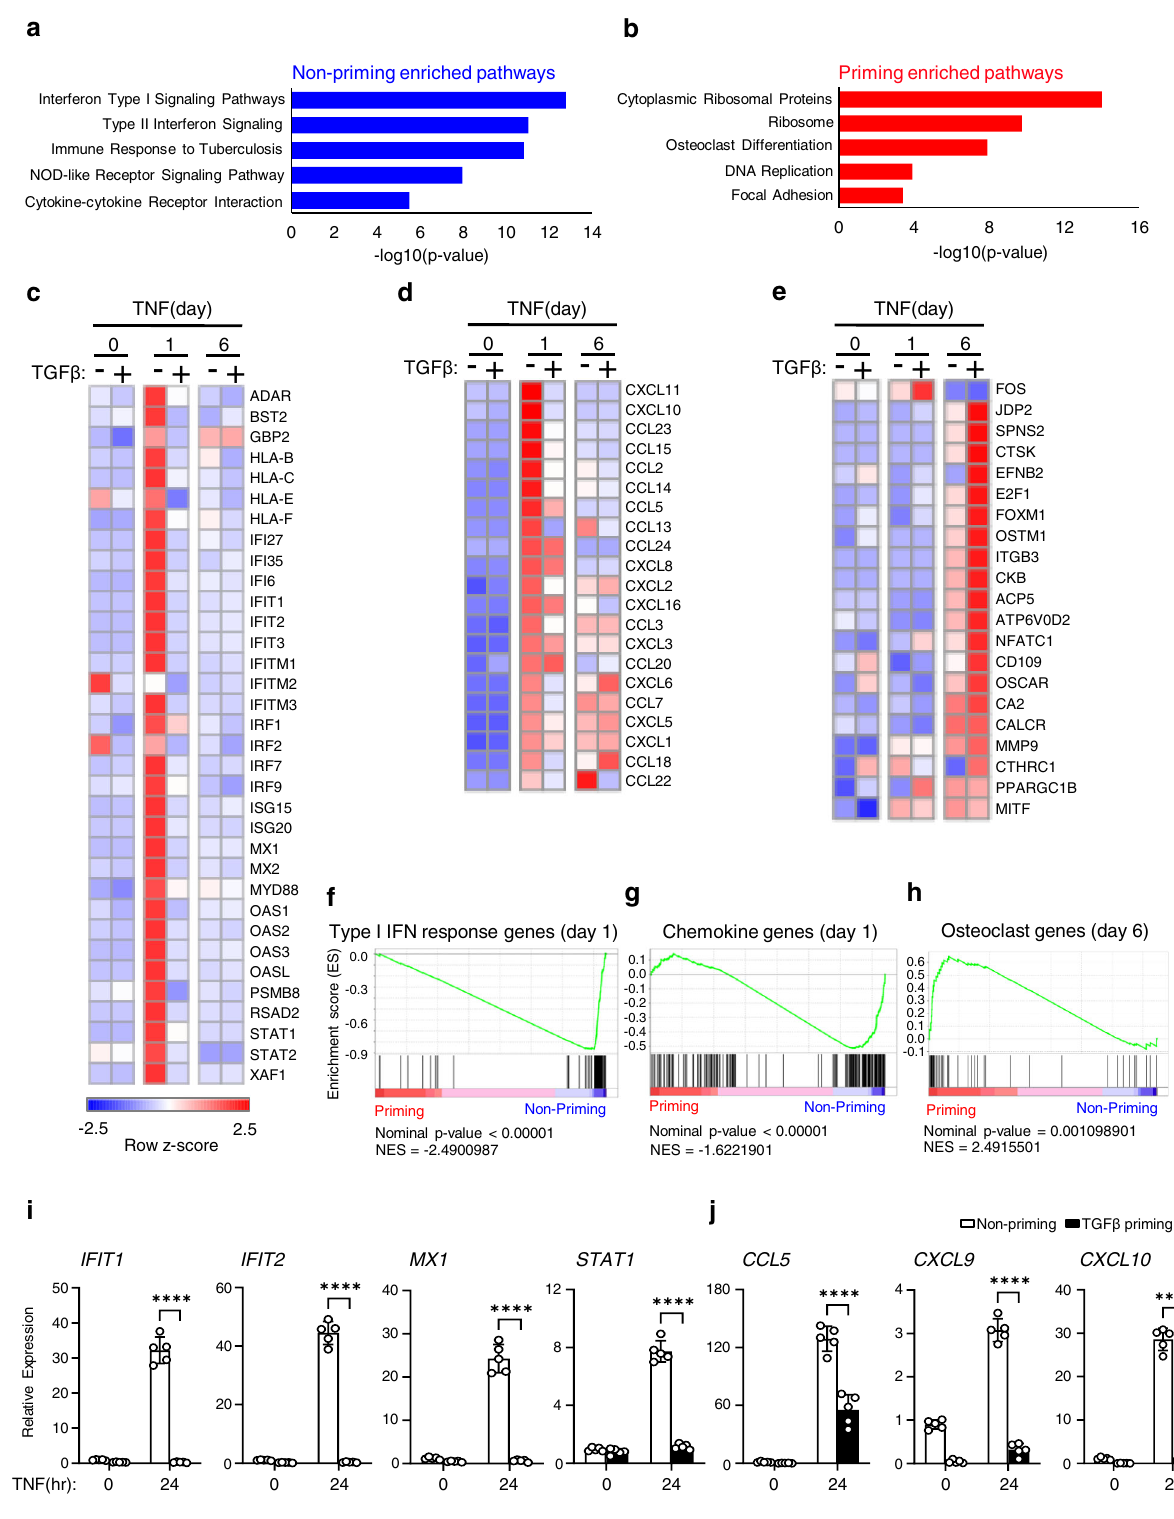
without TNF stimulation. These fi ndings indicate that TGF β sible for gene induction by subsequent stimulatory signals. One increased by TGF β priming at baseline but enhanced after TNF stimulation (Fig. 4n). With TGF β priming, TNF stimulation further increased chromatin accessibility at some OC gene loci